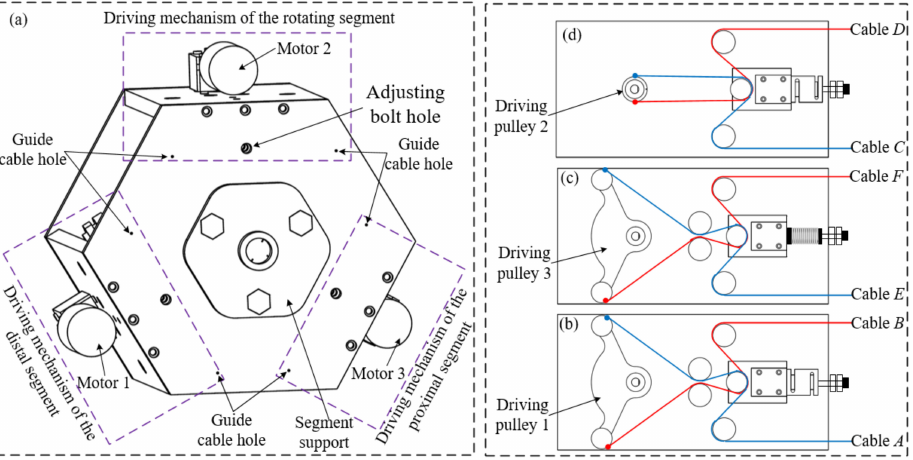
Figure 8. The driving mechanism of the robot. ( a ) The structure of the driving mechanism. ( b ) The driving mechanism of the rotating segment. ( c ) The driving mechanism of the distal segment. ( d ) The driving mechanism of the distal